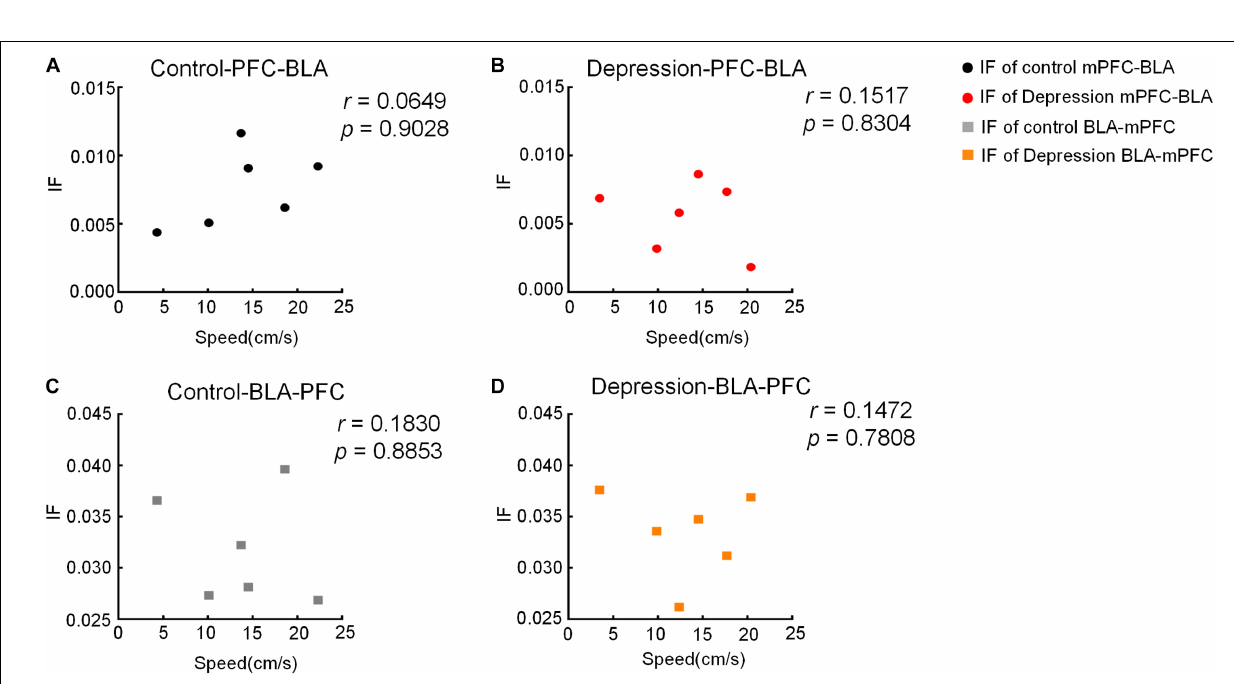
FIGURE 10 | Correlation between moving speed and IF in the OFT. (A,B) There is no significant correlation between moving speed and IF of the mPFC-BLA in the (A) control and (B) depression group. (C,D) There is no significant correlation between moving speed and IF of the BLA-mPFC in the (C) control and (D) depression